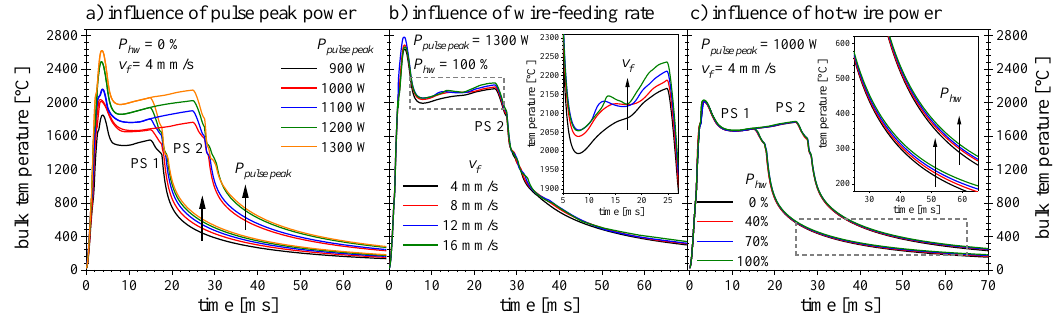
Figure 21. Bulk temperature-profiles from numerical simulations of one laser pulse for various parameter settings: influence of the ( a ) pulse peak power P pulse peak , ( b ), wire-feeding rate v f and ( c ) hot-wire power P hw . Shown is the transient mean-bulk temperature in the welding zone.